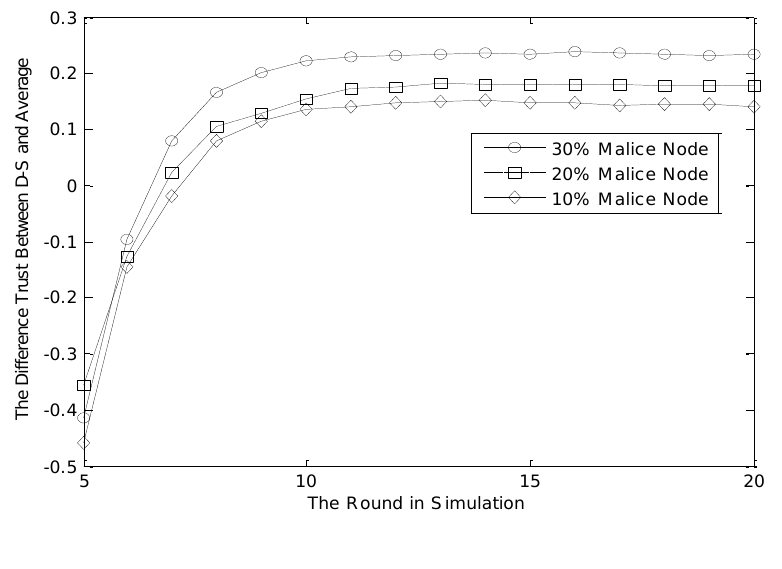
Figure 5. The comparison between NBBTE and weighed-average